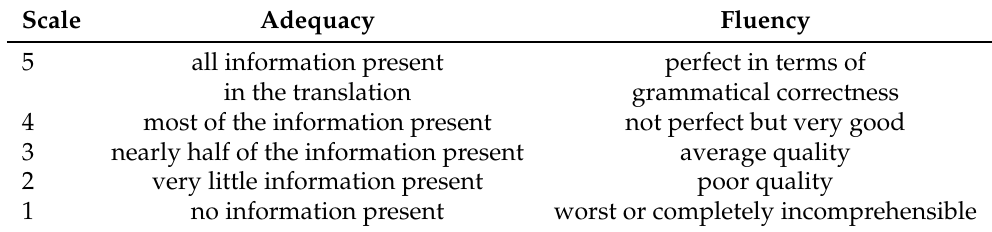
Table 4. Description of Adequacy and Fluency.